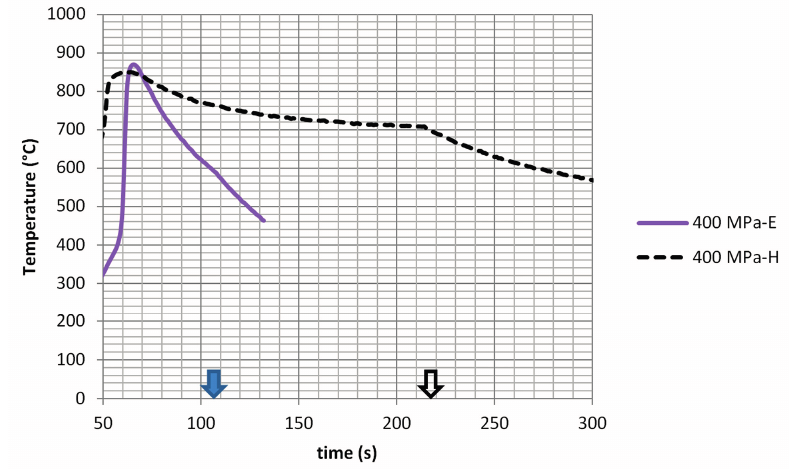
Figure 3. Heating curves of the Fe + Co + Ni + Cu + Al powder compacts measured by optical pyrometer: microwave heating at 240 W forward power, 5800 MHz, in predominant electric field (suffix -E) or magnetic field (suffix -H) regions of the microwave applicator. Microwave exposure is prolonged after the reaction is terminated, until the time indicated by the arrow, resulting in a slope change during